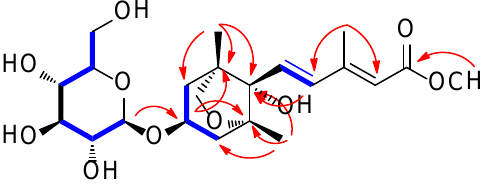
Figure 2. 1 H- 1 H COSY ( ) and key heteronuclear multiple bond correlation (HMBC) ( ) correlations for compound 1 .